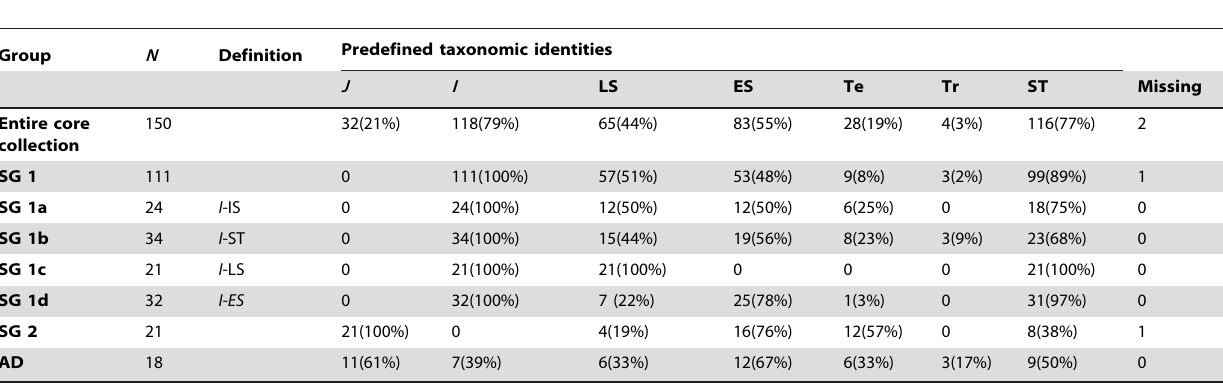
Group N Definition Predefined taxonomic identities